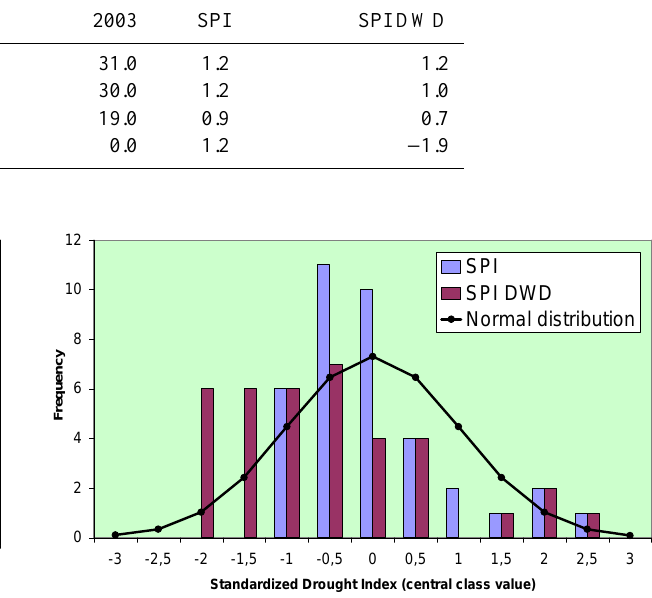
Fig. 2: SPI and SPI DWD as function of monthly precipitation in August 1971-2007 at a grid point over Greece (21.0E 38.0N). Precipitation totals for each year of that period are Figure 2. SPI and SPI DWD as function of monthly precipitation displayed in ascending order. Parameters in this example: number of years n=37, relative in August 1971–2007 at a grid point over Greece (21.0 ◦ E 38.0 ◦ N). frequency of zero precipitation p0=6/n=0.162. Precipitation totals for each year of that period are displayed in as- cending order. Parameters in this example: number of years n = 37, relative frequency of zero precipitation p 0 = 6 / n = 0 . 162. The disadvantage of the SPI DWD is that the values of its distribution are still not normally distributed in arid regions (see Fig. 3). However, in this case even the original SPI is not normally distributed, because the distribution of the precipitation values is inappropriate, since there are numerous small precipitation values. To achieve the aim of correctly representing very small precipitation values via very small SPI values we had to drop the normal distribution.